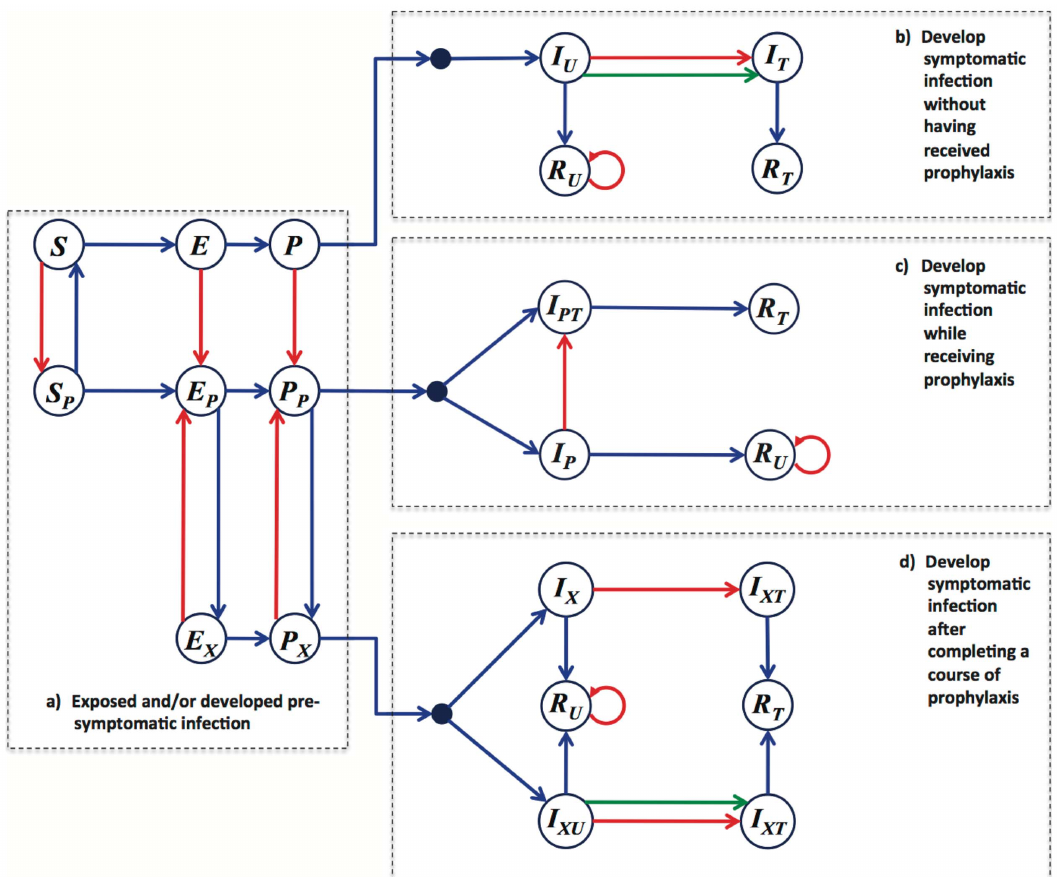
Figure 7. Compartmentalization of the model structure with four main blocks: (a) prior to becoming symptomatically infectious; (b) develop symptomatic infection without having received prophylaxis; (c) develop symptomatic infection while receiving prophylaxis; (d) develop symptomatic infection after completing a course of prophylaxis. Subscripts have the following meaning: ( P ) the agent is currently undergoing a course of prophylaxis; ( X ) the agent is (was) receiving prophylaxis during the pre-symptomatic or exposed